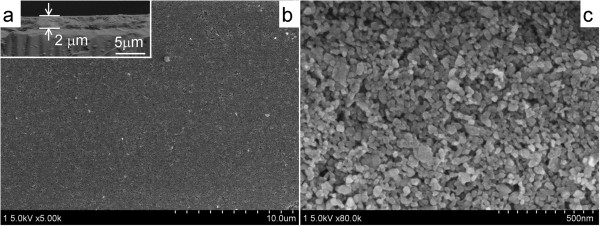
SEM images of nanoporous TiO2 film: (a) cross-sectional, (b) low-, and (c) high-magnification SEM images of the surface.